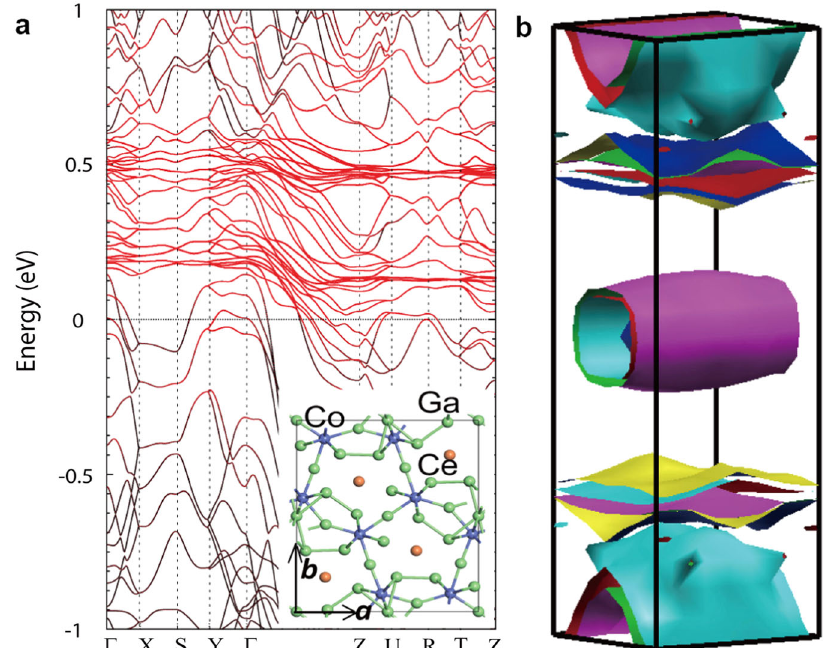
Fig. 6 First-principles calculations for the band structures and Fermi surfaces. a The band structures, showing fl at f -electron bands within the ab plane and a spin-orbit splitting of about 0.3 eV. The inset shows the unit cell containing 4 formula units and a total number of 44 atoms. b The Fermi surfaces showing four fl at sheets from the four Ce f -chains along the c -axis and several cylindrical sheets from the Co/Ga-layered structure perpendicular to the b -axis. The colors have no special meaning and are generated automatically from the WIEN2K code to distinguish different Fermi